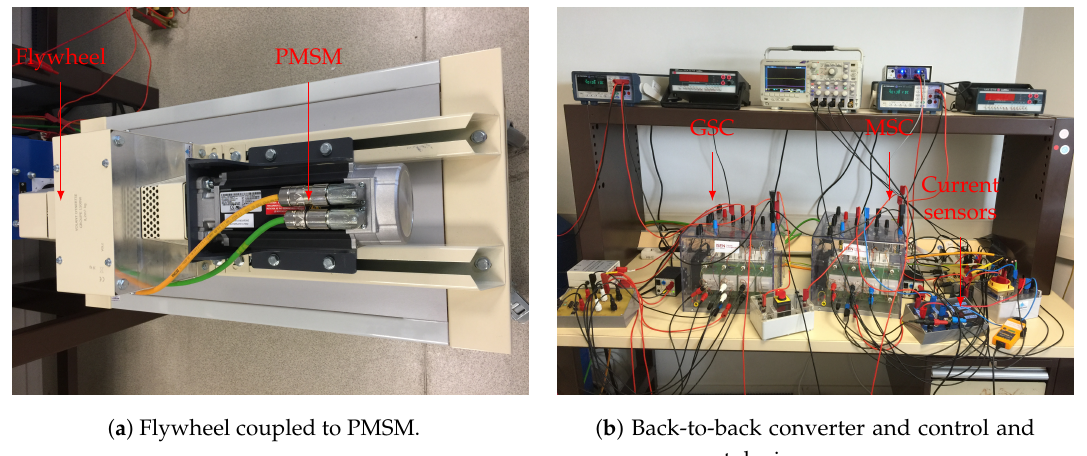
Figure 11. Flywheel and associated power